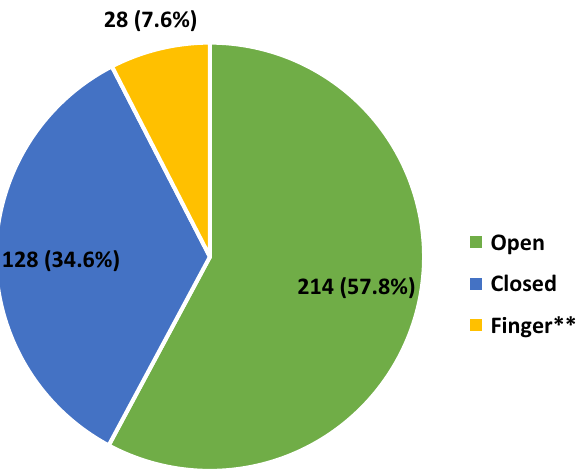
Figure 2. Fracture reduction method. ** "Finger reduction" = reduction achieved with one finger of the surgeon dipped into the fracture site via a mini incision of